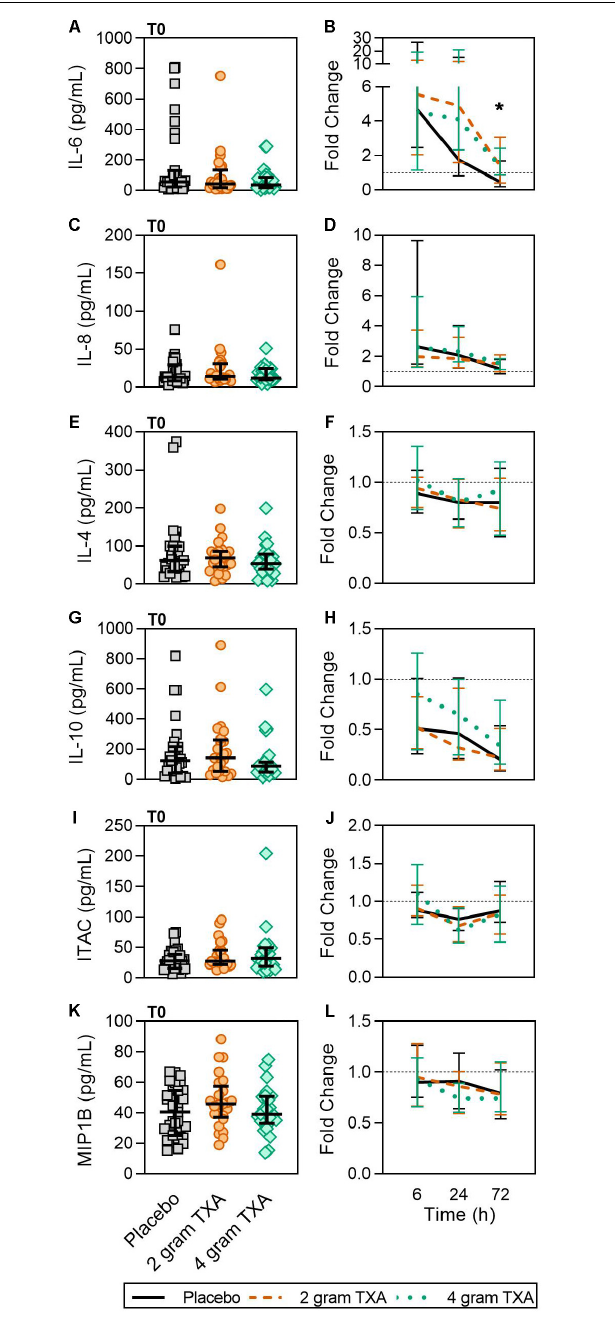
FIGURE 7 | TXA administration increases circulating levels of IL-6. For T0, data are represented as individual points with median + IQR for error bars. For all kinetic data, fold change was calculated as [(frequency/MFI/concentration of a given population/analyte at the given time | | T6,T24,T72| |) ÷ (frequency/MFI/concentration of the same population/analyte at T0)]. Data are displayed as line graphs (fold change, median + IQR). The dashed line placed at y = 1 represents T0, or baseline. Placebo, n = 29; 2 g TXA, n = 24; 4 g TXA, n = 25. Statistical differences between the 4 g TXA and placebo groups at each given time point, as calculated via Kruskal-Wallis, are noted as follows: p < 0.05, *; p > 0.05, not significant and not denoted